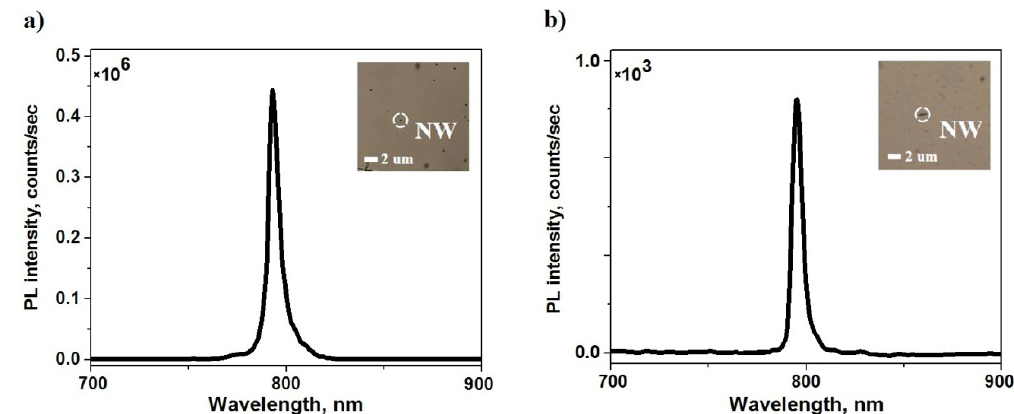
Figure 2. Spectra of microPL of the single NW with QD vertically standing on the substrate ( a ) as shown in Figure 1c, and lying on the substrate ( b ) as show in Figure 1d. The embedded pictures in ( a , b ) show the optical microscope images of the standing and lying single NW, respectively.